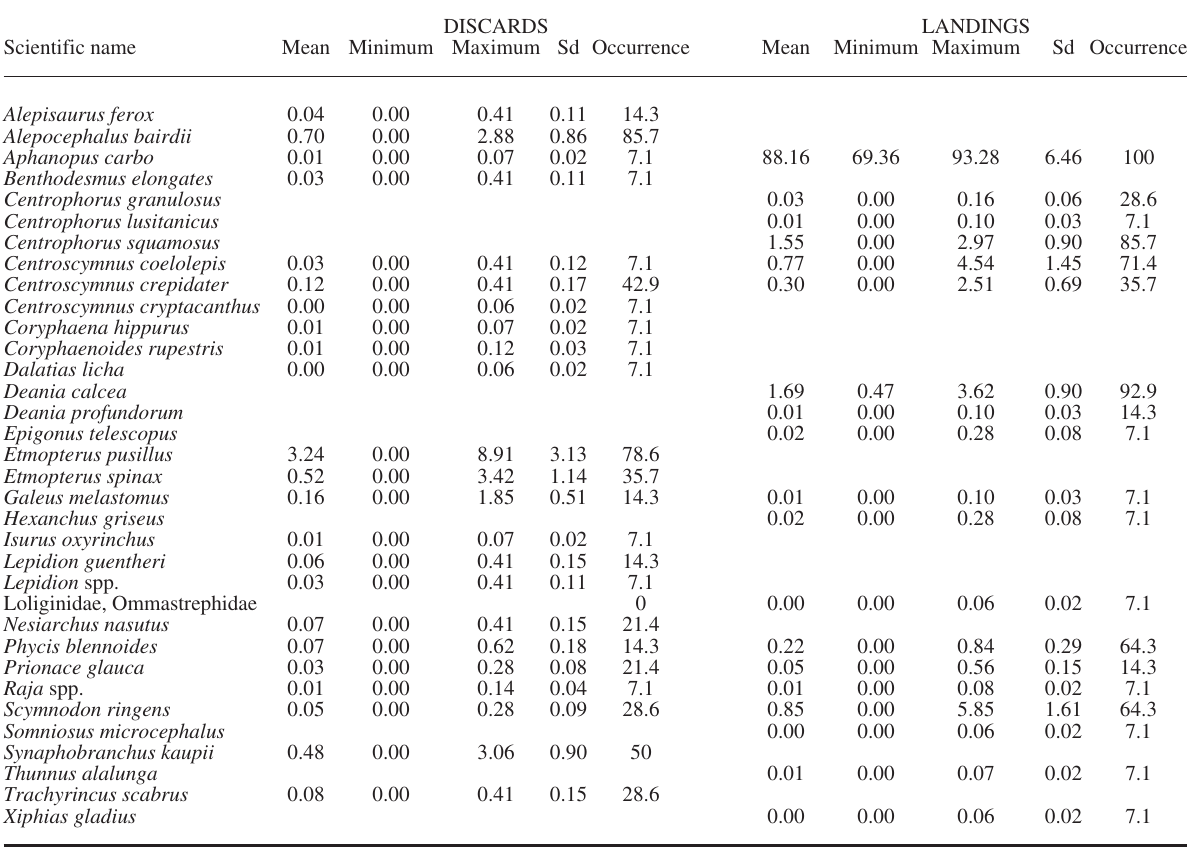
Table 6. – descriptive statistics (relative percentage of the total catch) of discarded and landed species numbers and occurrences. sd, standard deviation.